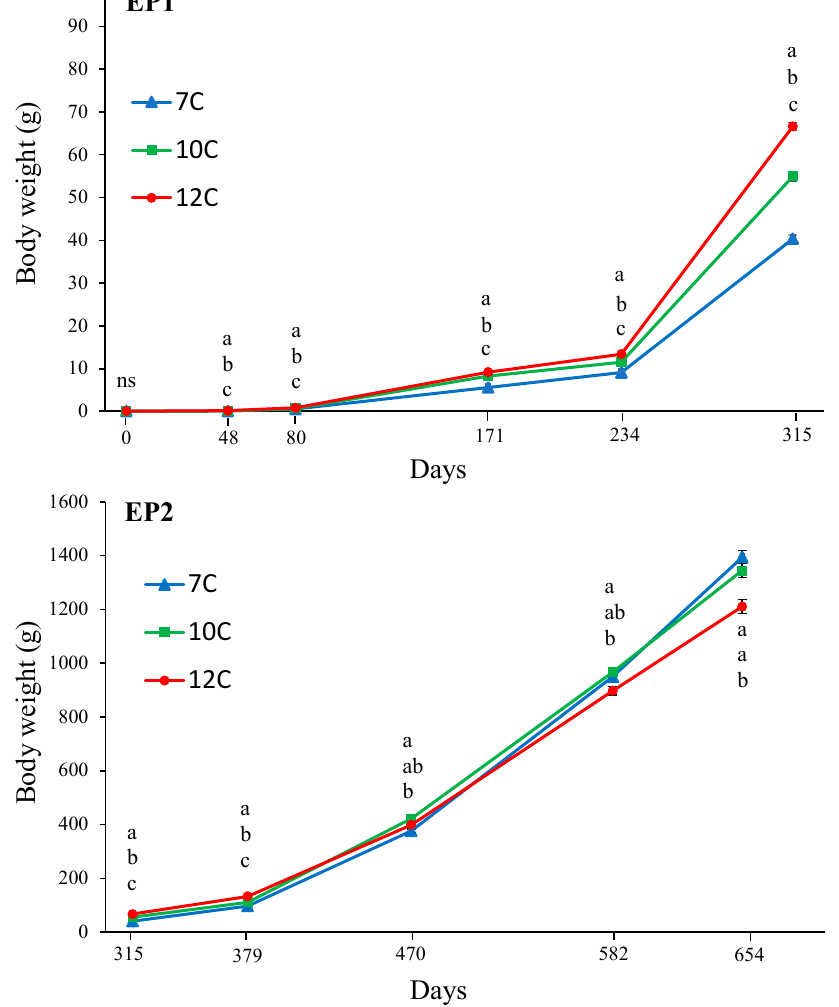
Figure 1. Mean growth in W of Arctic charr reared at three different temperature regimes: 7C ( ▲ ), 10C ( ■ ), and 12C ( ● ) during the juvenile stage in experimental phase 1 (EP1). Experimental phase 2 (EP2) started on day 315 when the temperature was adjusted to 7 °C in all groups. In all groups the salinity was increased from 4 to 22 ppt on day 379 after the fish had been transported from the Verid to MFRI research station. Different lower-case letters denote significant differences between groups at the 5% level of significance.